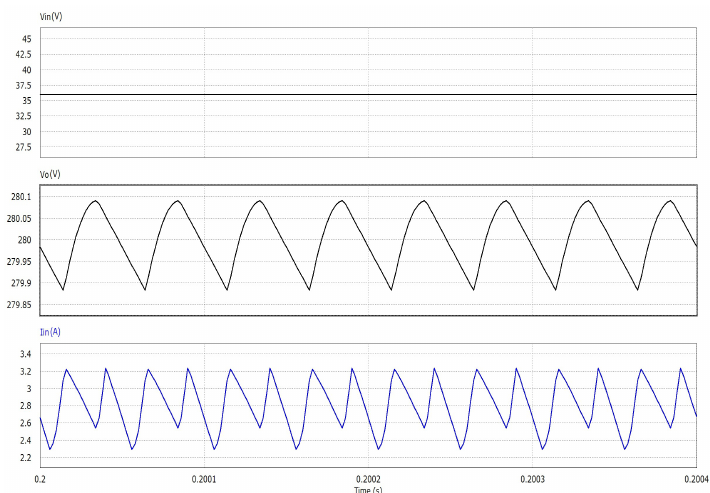
Figure 13. PSIM simulation of input voltage, input current and output voltage.